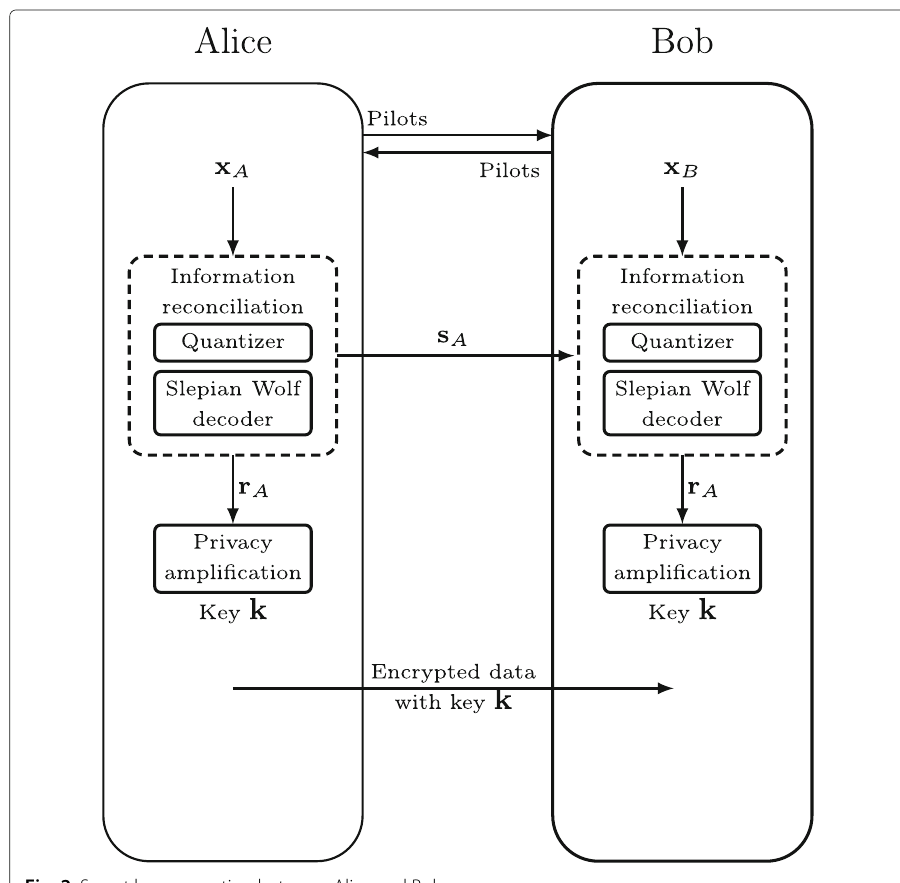
Fig. 2 Secret key generation between Alice and